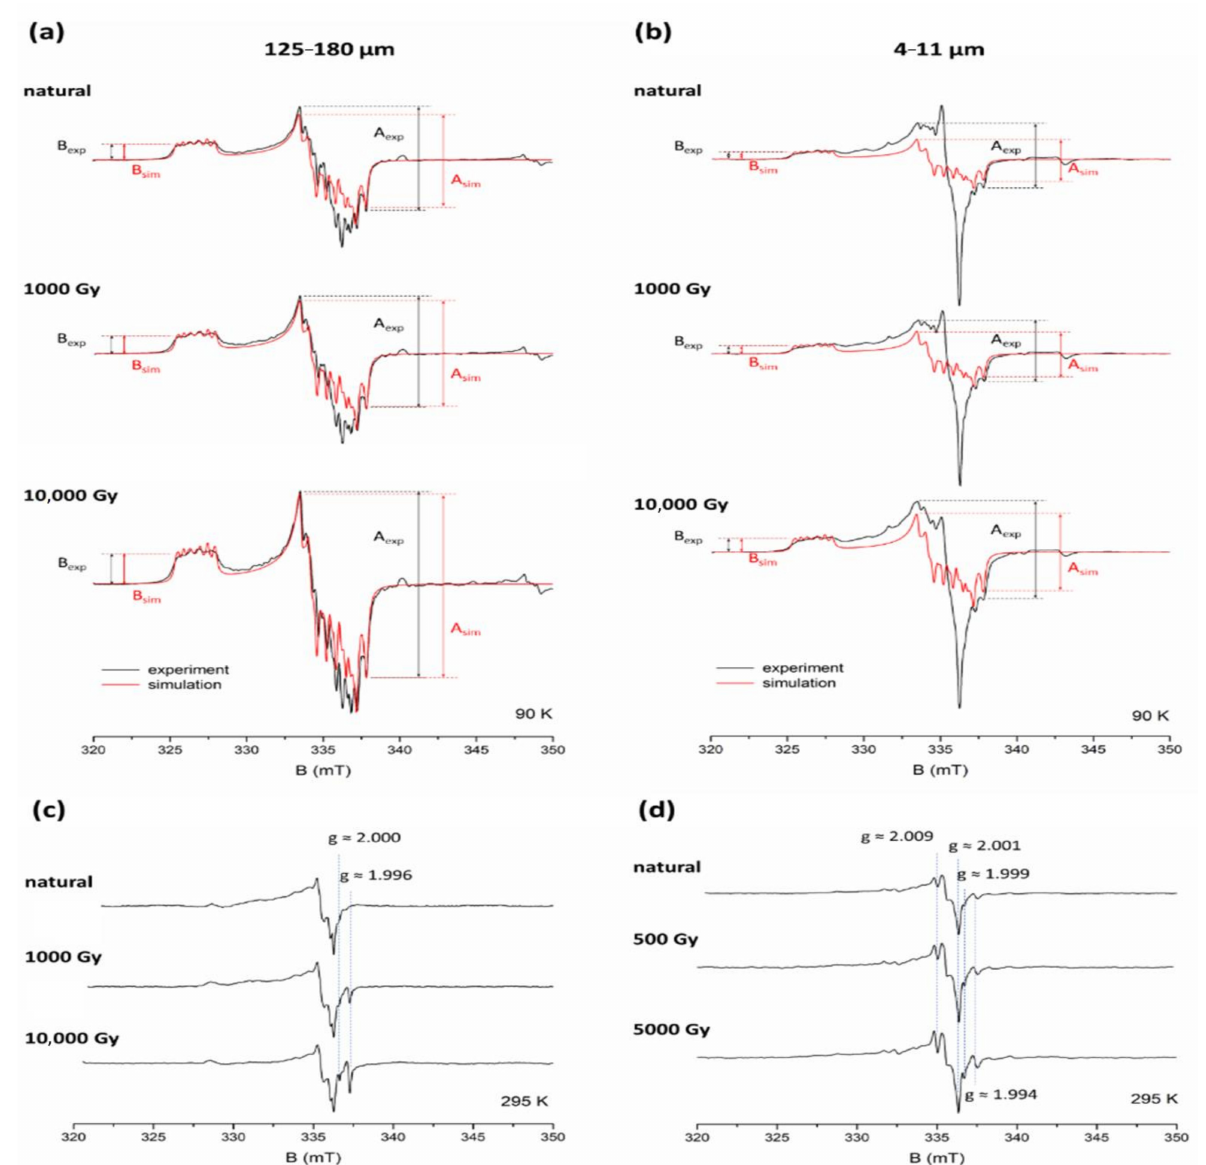
Figure 2. EPR spectra of the coarse (125–180 µ m) and fine (4–11 µ m) fraction of sample ROX 1.14, natural and additionally irradiated with 1000 and 10,000 Gy, recorded at 90 K (( a , b ), respectively) and at room temperature (( c , d ), respectively), and simulated spectra of Al-h signal (in red). Amplitudes A exp , A sim , B exp and B sim are marked with arrows. Major dose-dependent signals observed at room temperature are marked with blue dashed lines. The 90 K spectra for coarse grains are multiplied by a factor of